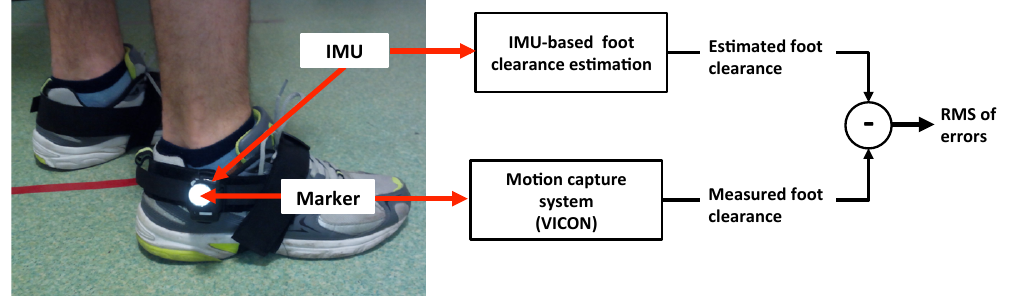
Figure 3. Experimental setup and validation of IMU-based foot clearance